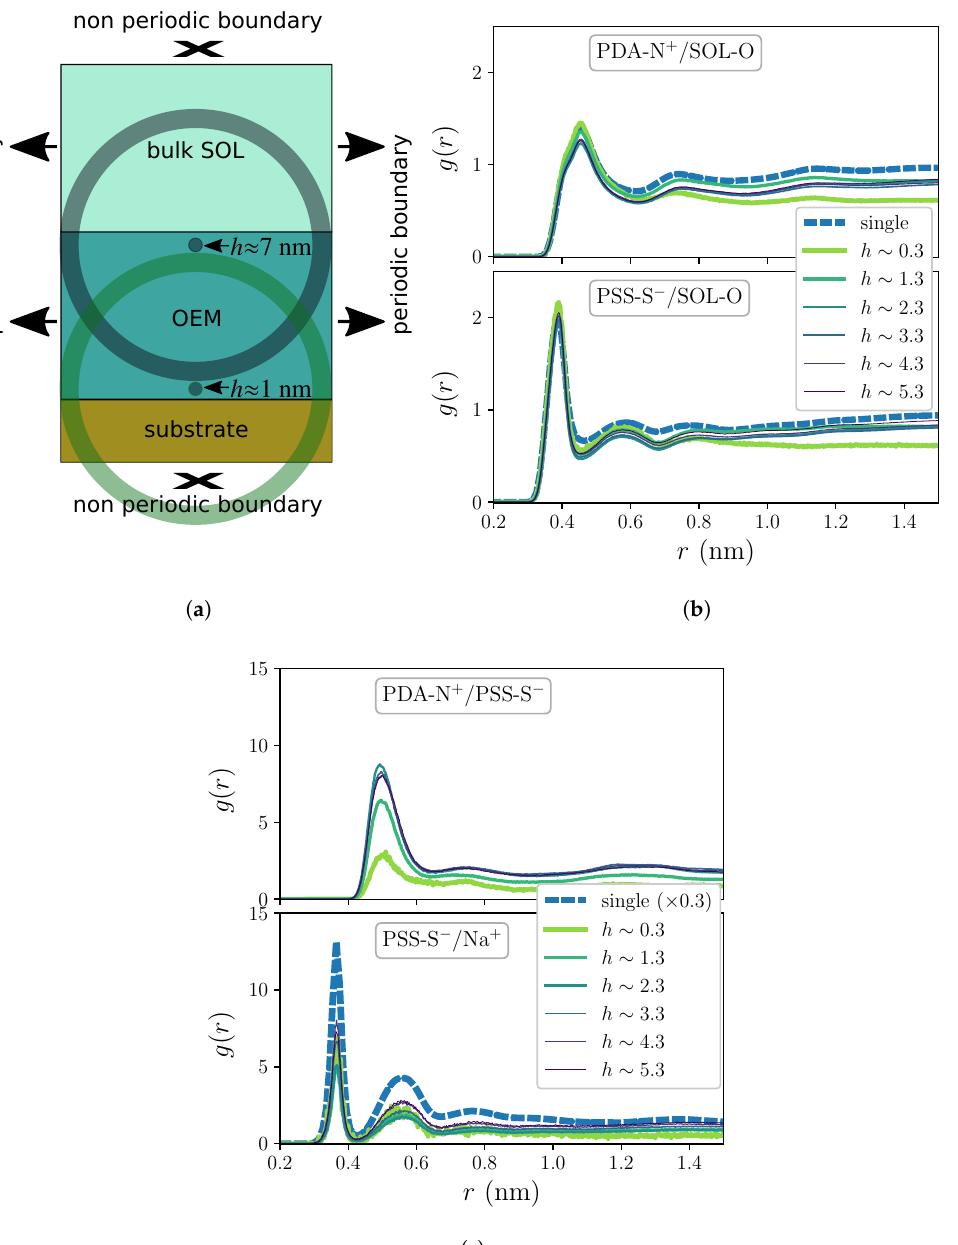
Figure 2. ( a ) Sketch of the system illustrating the maximum range at which one can sample correlation functions and their different bias depending on the distance to the substrate of the reference position, h . ( b , c ) Selected RDFs of different pairs obtained for single chains and for the OEM system when exposed to pure solvent conditions. Curves for OEM correspond to different distances to the substrate, h , calculated from a partitioning of the positions of the reference groups in horizontal slices of thickness ∆ h = 1 nm. ( b ) Distributions of waters around PDADMAC (upper panel) and PSS (lower panel) charged groups. ( c ) Distributions obtained for each charge pairing within the